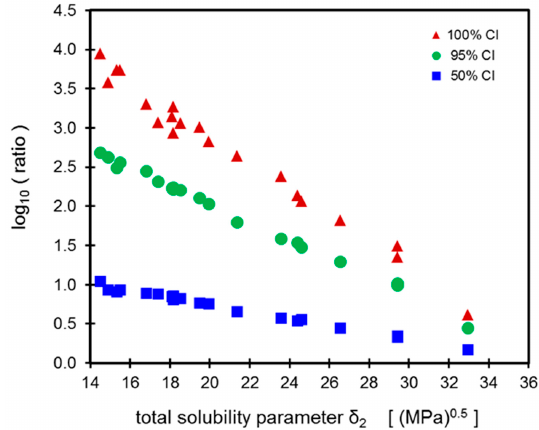
Figure 2. Relative width of the confidence intervals (CI) of L -ascorbic acid solubilities at 25 °C from the Monte Carlo simulation. The width is expressed as ratio = UCL/LCL of the respective upper and lower confidence limit of the numerical simulation results. The finite number of simulations makes extreme values improbable to occur and, in line with the GUM approach, the 95% CI or interquartile range should be considered to provide a meaningful